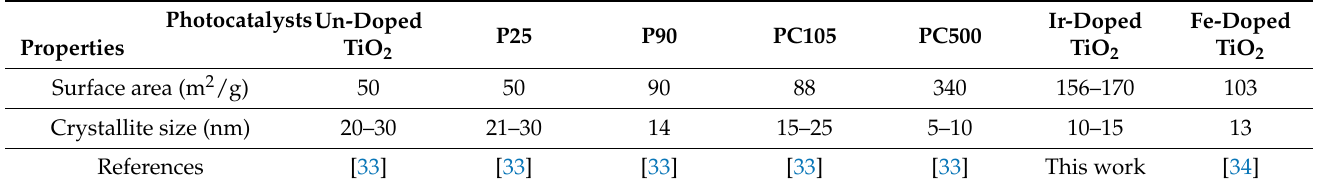
Figure 6. The specific surface area of Ir-doped TiO 2 photocatalysts with different iridium concentra- tions and some commercially available photocatalysts. Table 2. Surface area and crystallite size of photocatalysts.